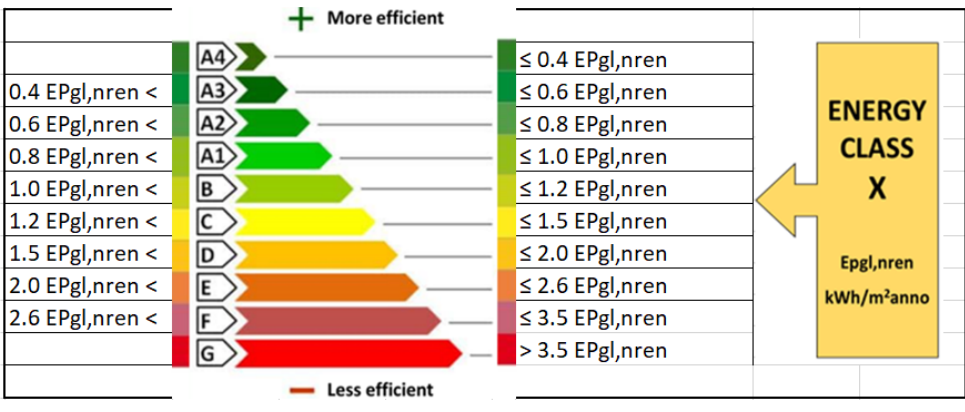
Figure 2. Italian energy classes based on EP gl,nren [26].